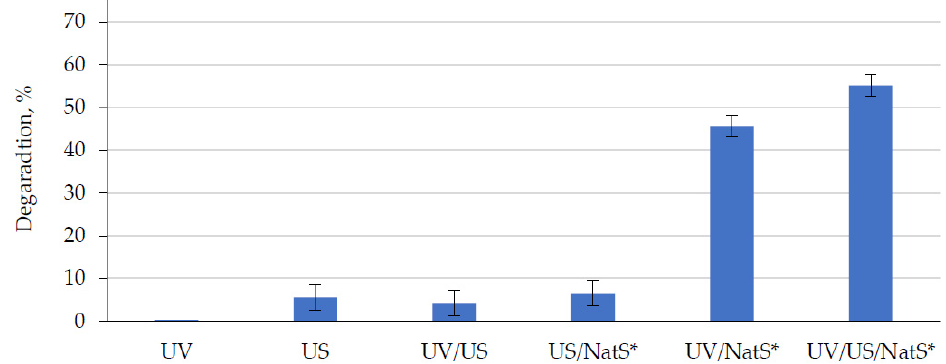
Figure 4. 4-chlorophenol degradation under UVA LED (365 nm) and/or ultrasonic (1.7 MHz) irra- diation using calcined natural sphalerite (NatS*, 900 °C, 1 g/L, 75 μ m sieve) [4-CP] 0 = 10 mg/L, exposure time = 1 h. exposure time = 1 h.